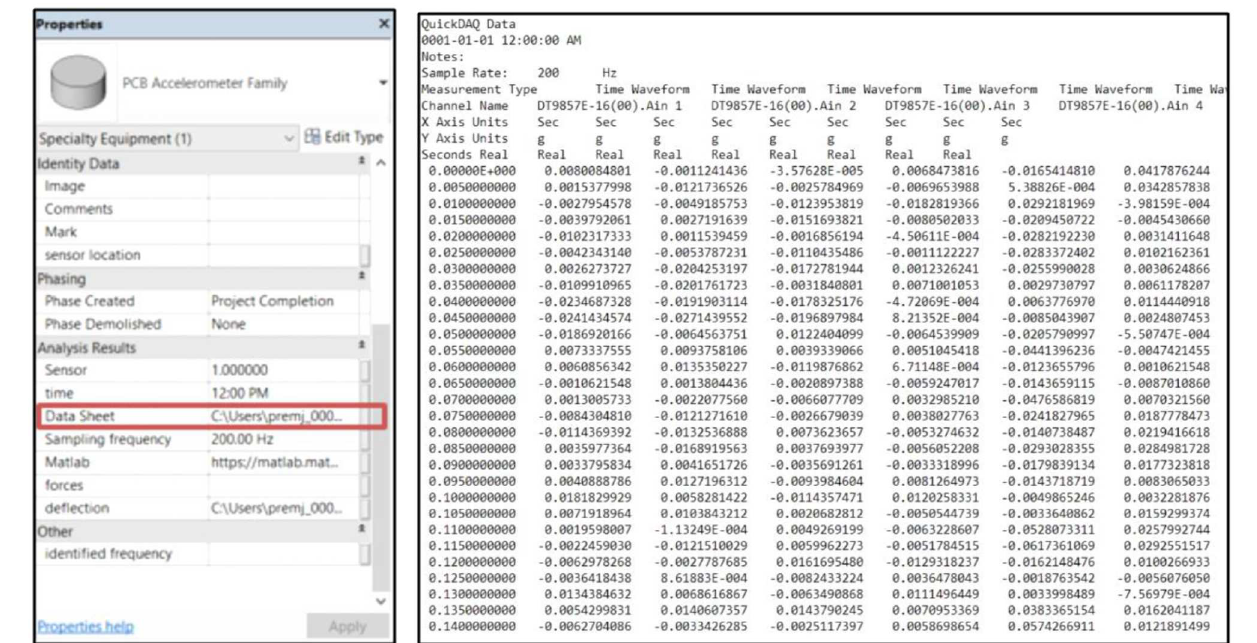
Frontiers in Built Environment |